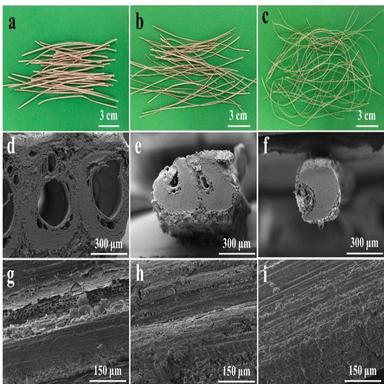
Photographs of RFL (a), RFM (b) and RFS (c), SEM cross-section images of RFL (d), RFM (e) and RFS (f), and SEM longitudinal section images of RFL (g), RFM (h) and RFS (i).